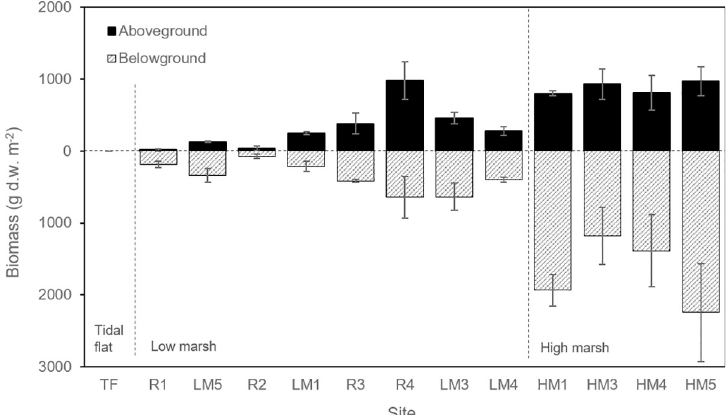
Fig 2. Aboveground and belowground biomass by site. Sites are arranged in order of increasing elevation. The elevations of the restored sites (R1 –R4) were within the range of other low marsh sites. Error bars represent standard error.